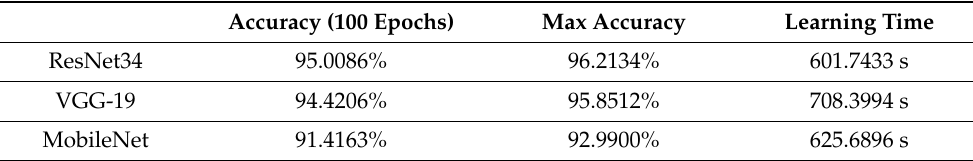
Table 2. Accuracy and learning time when running 100 epochs.